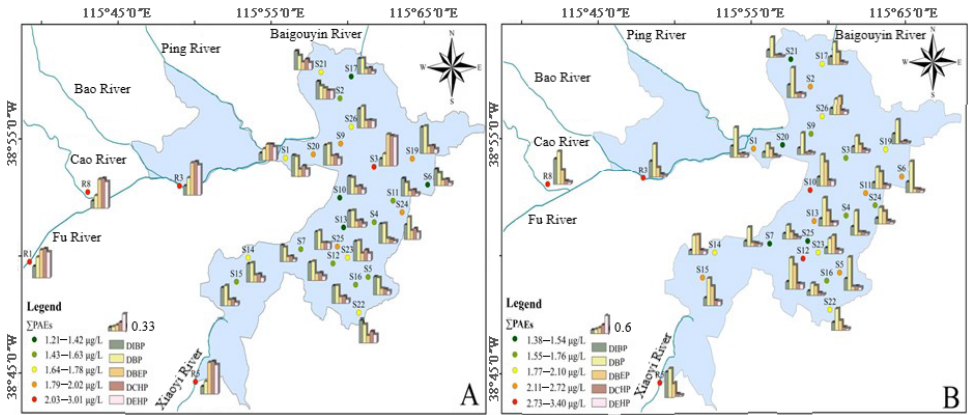
Figure 2. The concentrations of five preponderant PAE species and total concentrations detected in each sampling site in October ( A ) and May ( B ).